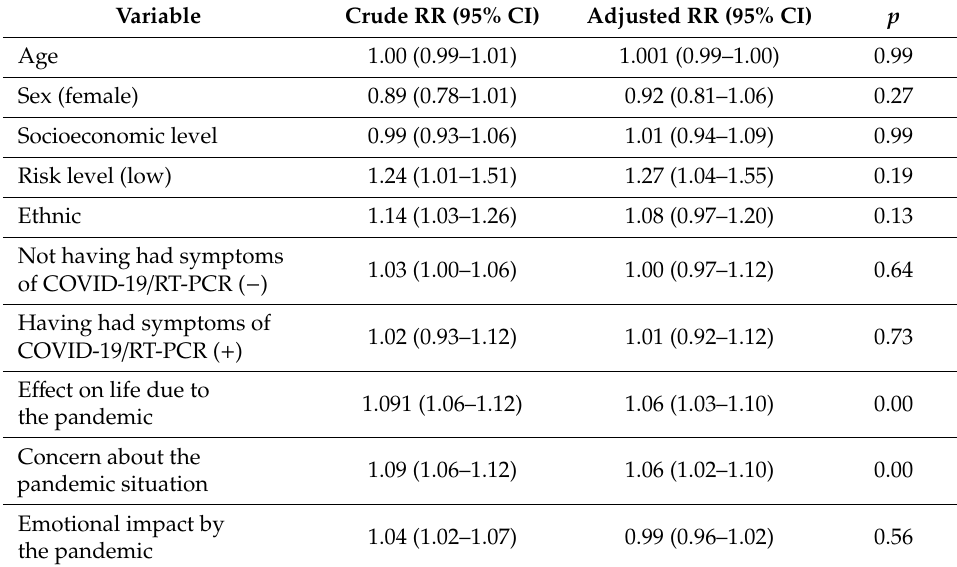
Table 3. Poisson regression model for risk perception of COVID-19 (RPQ) among airport workers.